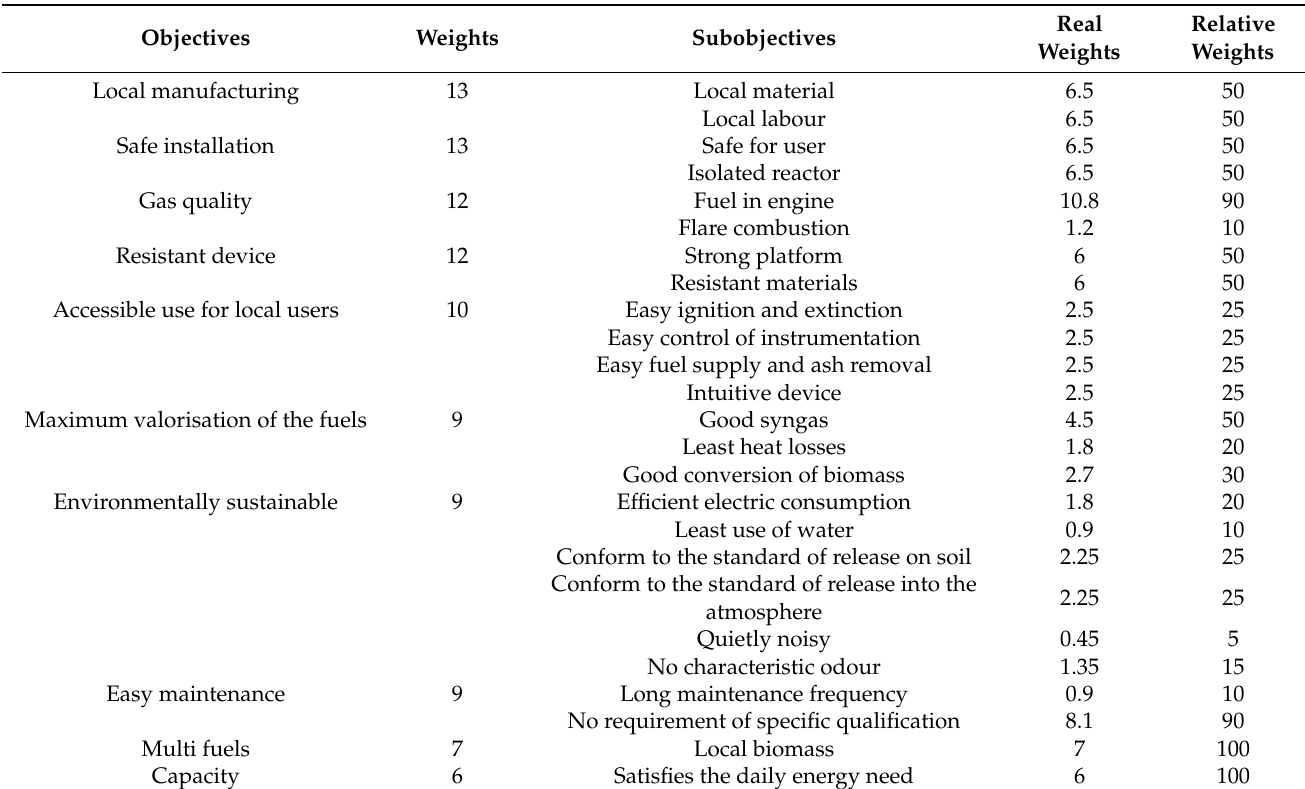
Table 1. Real and relative weights of the main objectives and subobjectives of the design of a gasifier for application in West